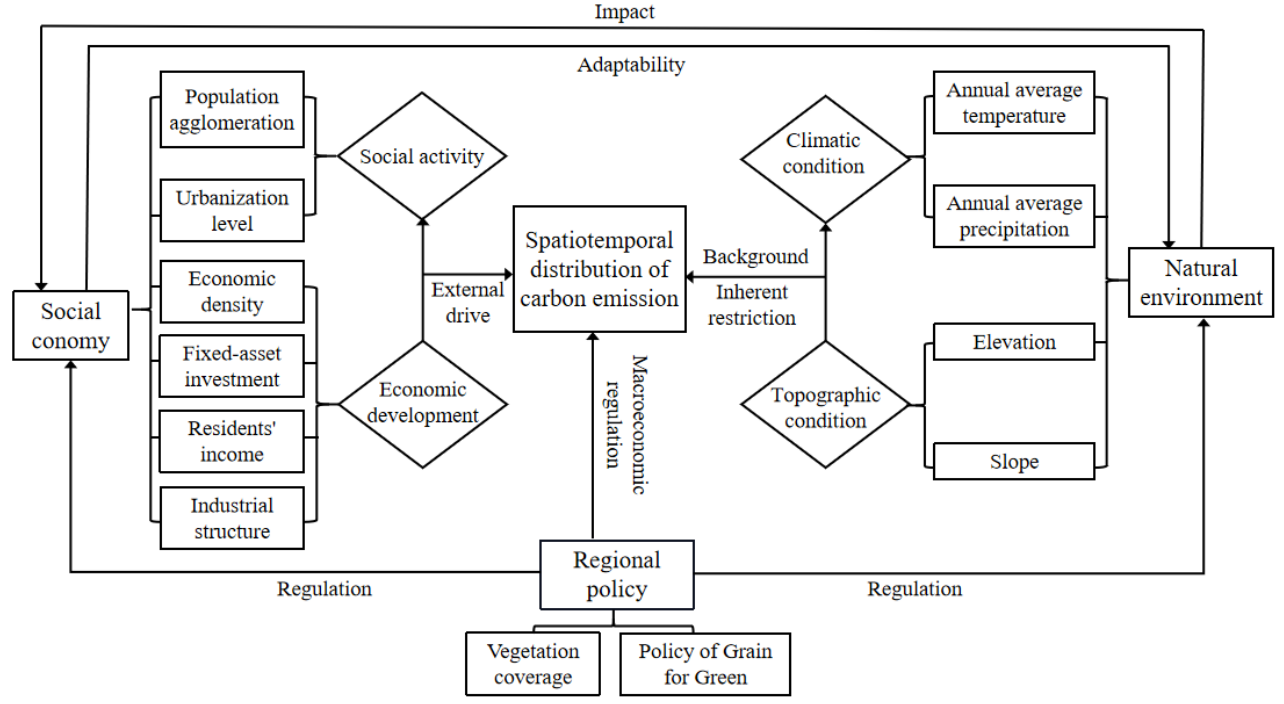
Figure 2. The analysis framework of influencing mechanism.